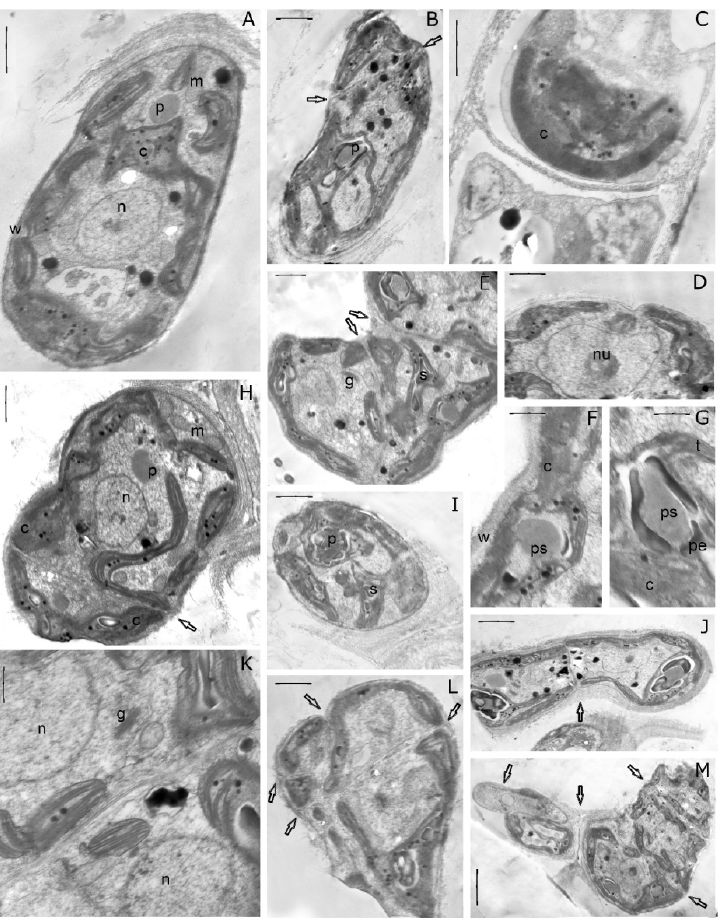
Figure 8. Ultrastructure of the studied strain IRK–A 341. ( A ) An individual cell with its cell wall and remnants of a filamentous cell wall on top of the cell; ( B ) a young cell ready to form a new filament, arrows pointed the cleavage furrow; ( C ) a fragment of the filament with a completely formed wall between cells, note the intact parietal chloroplast in forming cell; ( D ) a nucleus with heterogeneous nucleolus; ( E ) small filament with three cells, note different angles of cell divisions; ( F , G ) pyrenoids with intact stroma and almost absent ( F ) and developed ( G ) starch envelope; ( H ) just divided cell with a constriction on the left side; ( I ) possibly forming young cell in the filament; ( J ) a two-celled filament, formed by the division perpendicular to its long axis; ( K ) fragments of two young cells, forming new cell walls, note closely located nuclei, Golgi body and mitochondrion; ( L , M ) filaments with more than tree cells, note different plans of division. Designations: c—chloroplast,